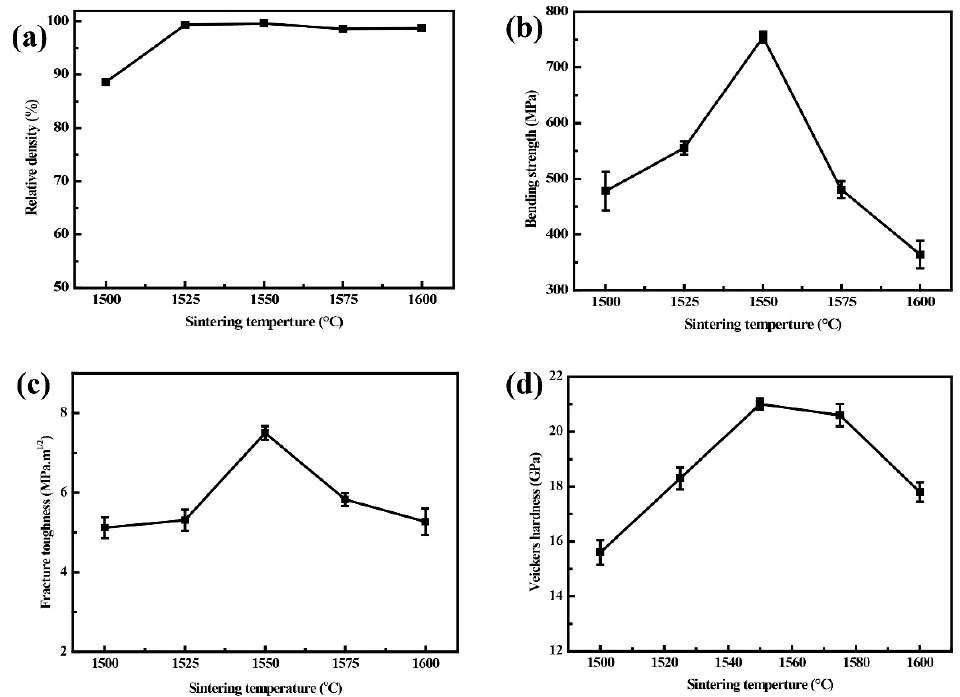
Figure 4. Changing trends of ( a ) relative density, ( b ) bending strength, ( c ) fracture toughness, and ( d ) Vickers hardness of Al 2 O 3 -G-M hot-pressed at different sintering temperatures.